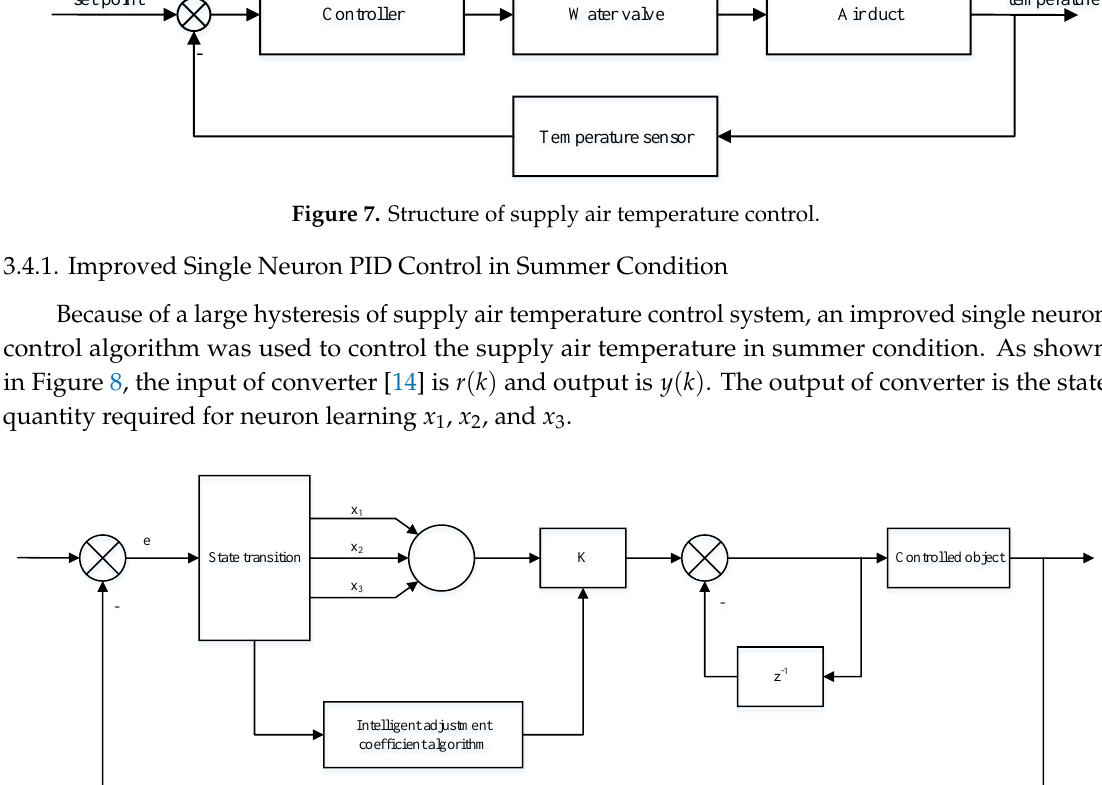
Figure 7. Structure of supply air temperature control.